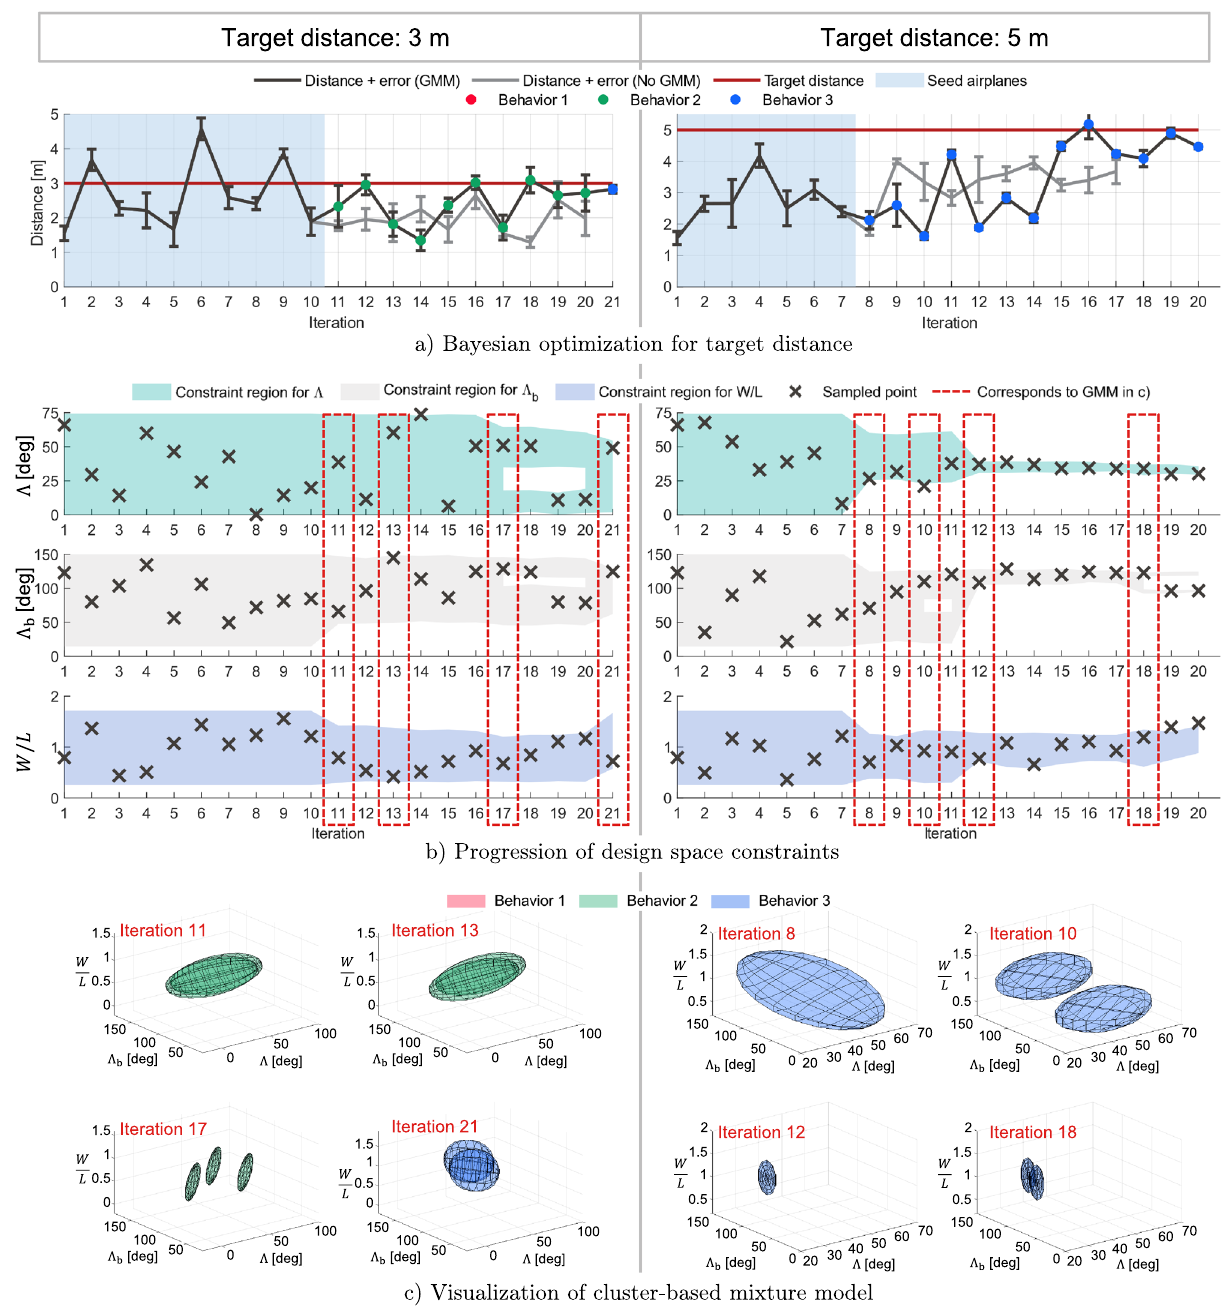
Figure 4. Experiment results of iteratively designing a paper airplane to fly a target distance of 3m ( left ) and 5 m ( right ). ( a ) GMM-assisted and unassisted Bayesian optimization results of flight distance at each iteration with dots indicating the behavioral cluster the optimizer searches in. ( b ) Visualization of the geometry space constraints at each iteration and the sampled points. ( c ) Visualization of the geometric search space created by the GMM at the indicated iteration number, also corresponding to the dashed red box in ( b